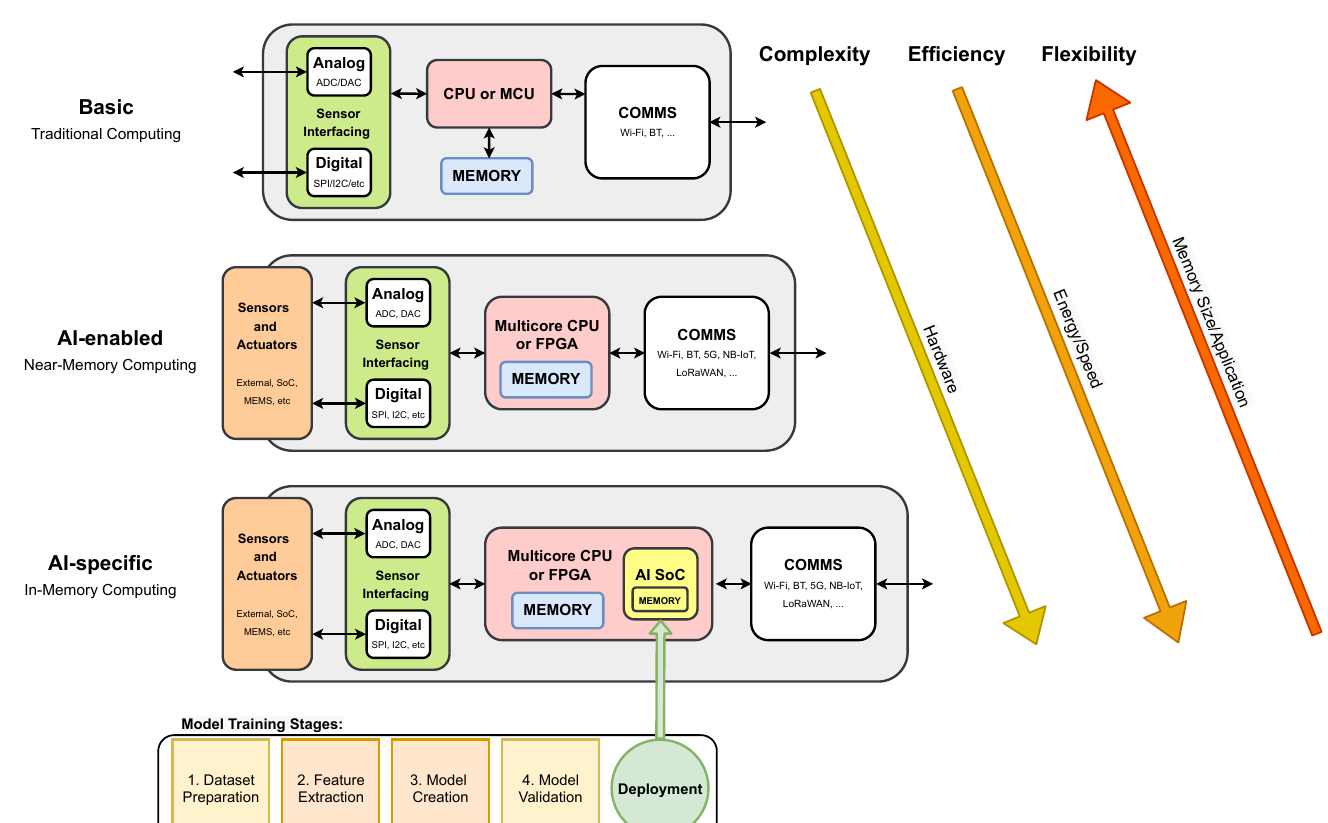
Deployment 4. Model Validation3. Model Creation2. Feature Extraction1. Dataset Preparation